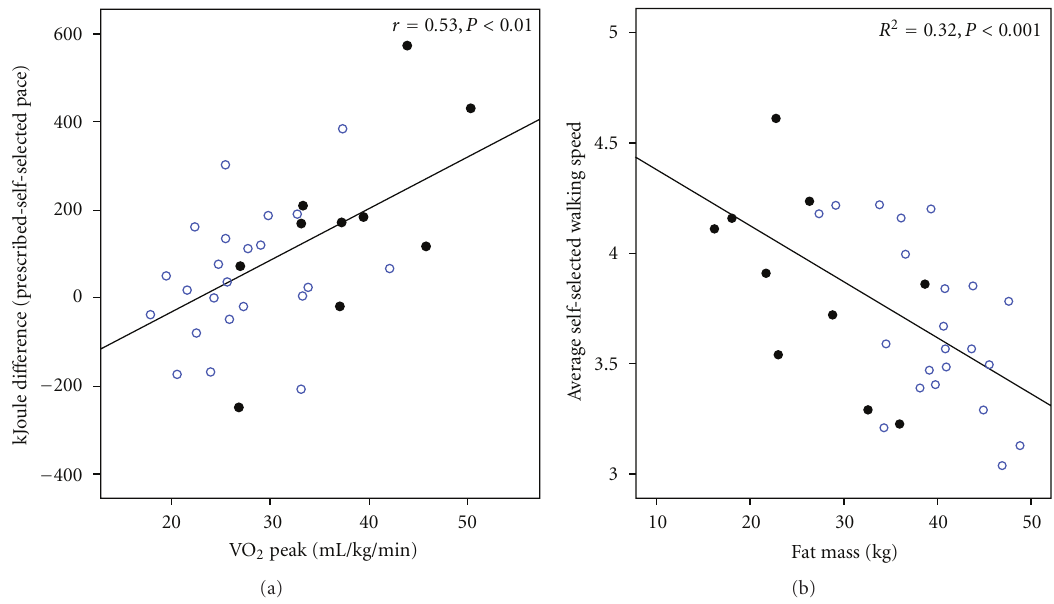
Figure 2: (a) The association between VO 2 peak and the di ff erence in energy expended between the prescribed and self-selected walking pace and (b) the association between self-selected walking speed and fat mass. (cid:2) Women, (cid:3)